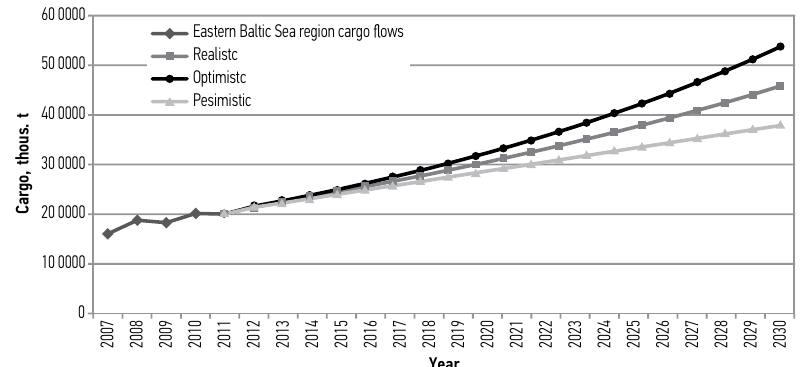
Fig. 1. Forecast of cargo flows of the Eastern Baltic Sea region ports up to the year 2030, thous.